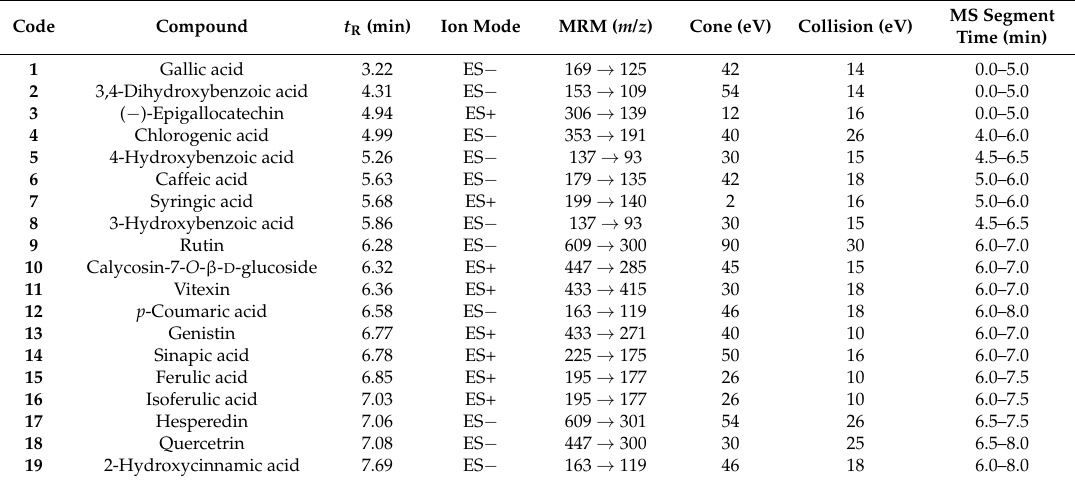
Table 1. Mass spectrometric conditions for each